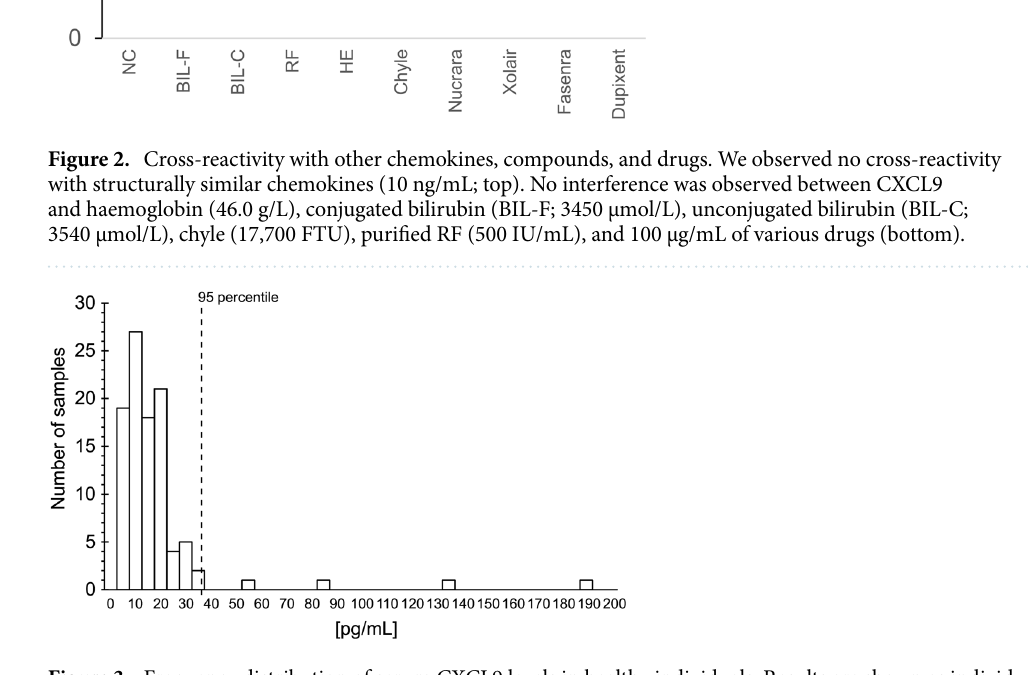
Figure 3. Frequency distribution of serum CXCL9 levels in healthy individuals. Results are shown as individual numbers of CXCL9 levels (open bars). The dashed line indicates the 95 percentile: 39.0